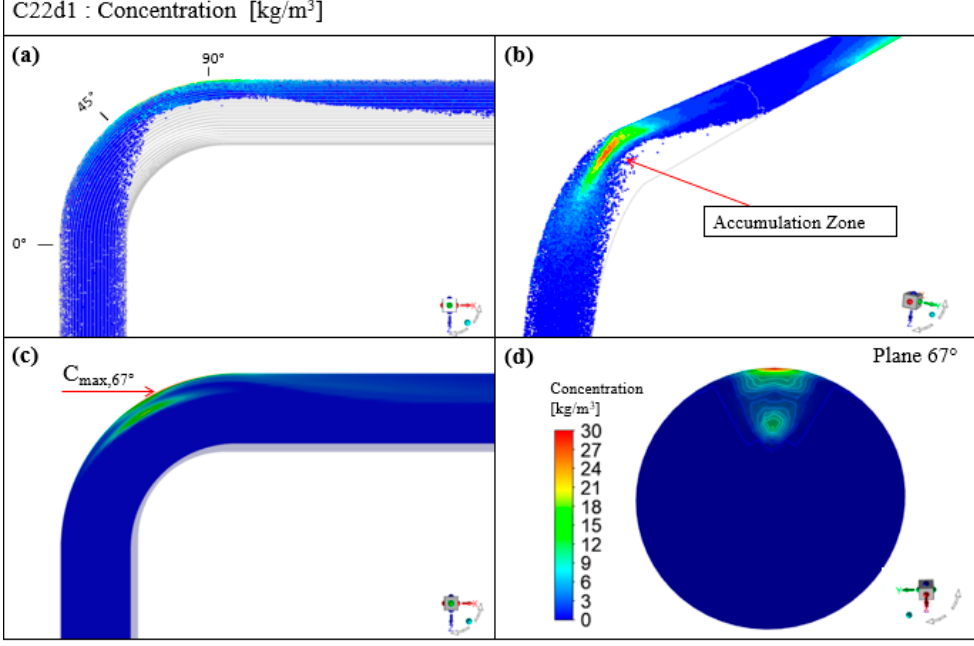
Figure A5. Results of particle concentration. Case C22d1. ( a ) Instant positioning of the X-Z plane particles ( b ) Instant positioning of the particles in 3D view ( c ) Concentration contour in the X-Z plane of the mid-section of the pipe ( d ) Concentration contour in the Z-Y plane of the maximum concentration cross section. Snapshots are taken for a statistically steady flow.